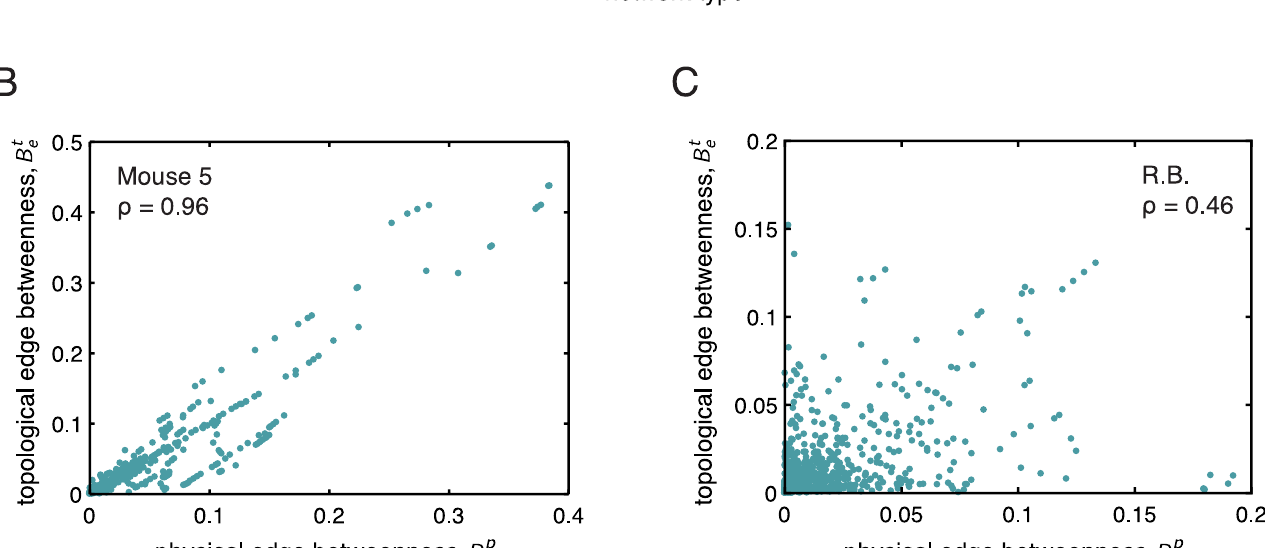
and the physical edge betweenness centrality B p . The curly e e for the network with the vs. physical edge betweenness centrality B p e e for vs. physical edge betweenness centrality B p e e